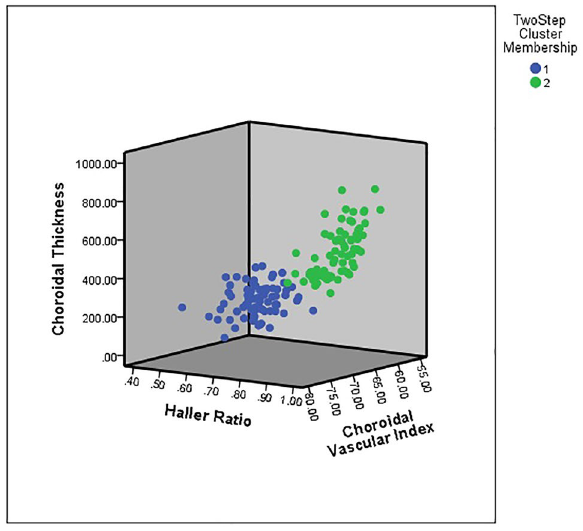
Figure 5. The t-SNE scatter plot based on three variables showing the successful process of clustering.